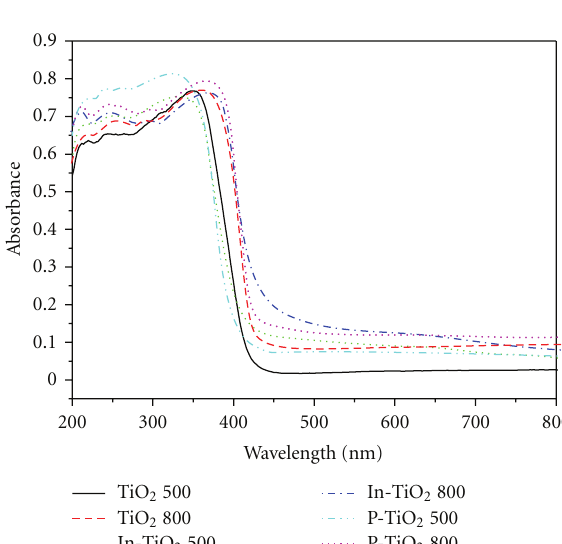
Figure 7: Photoluminescence spectra of 1.0mol% In, P incorpo- rated TiO 2